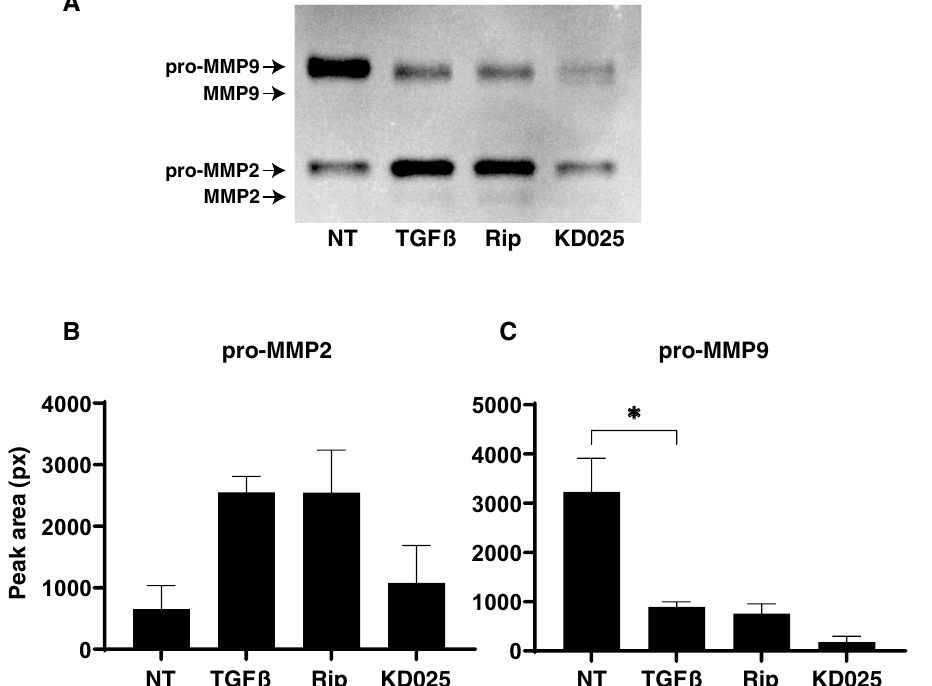
Figure 8. Gelatin-zymography of 3D HTM sphenoids. At Day 6, culture medium 7.5 out of 28 μl obtained from HTM 3D sphenoids and those treated by 5 ng/ml TGFβ2 in the presence of 10 μM ripasudil (Rip) or KD025 were subjected to gelatin-zymography. Representative their monochrome inversion image is shown in panel ( A ). The areas of the bands corresponding to pro-MMP2 (panel B ) or pro-MMP9 (panel C ) were qualified and plotted. All experiments were performed in duplicate using fresh preparations. Data are presented as the arithmetic mean ± standard error of the mean (SEM). * P < 0.05 (ANOVA followed by a Tukey’s multiple comparison